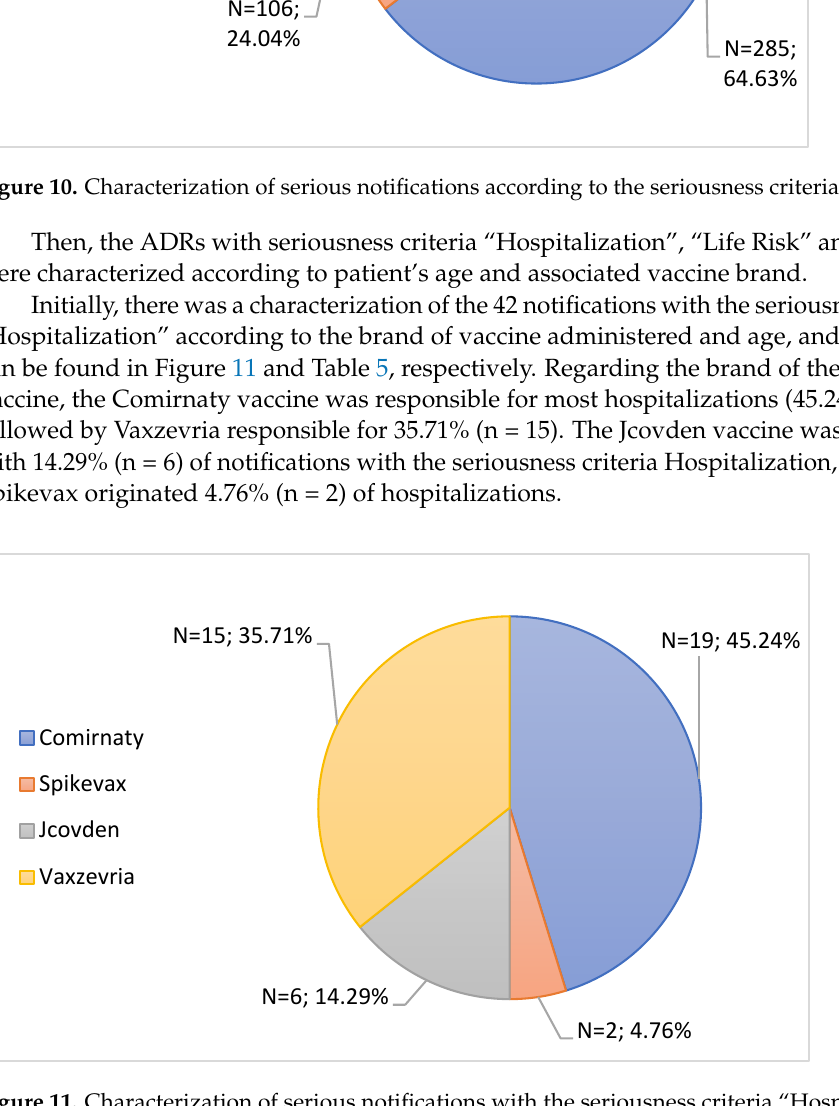
Figure 11. Characterization of serious notifications with the seriousness criteria “Hospitalization”, according to the brand of vaccine administered. Table 5. Characterization of serious notifications with the seriousness criteria “Hospitalization”, according to the associated age.